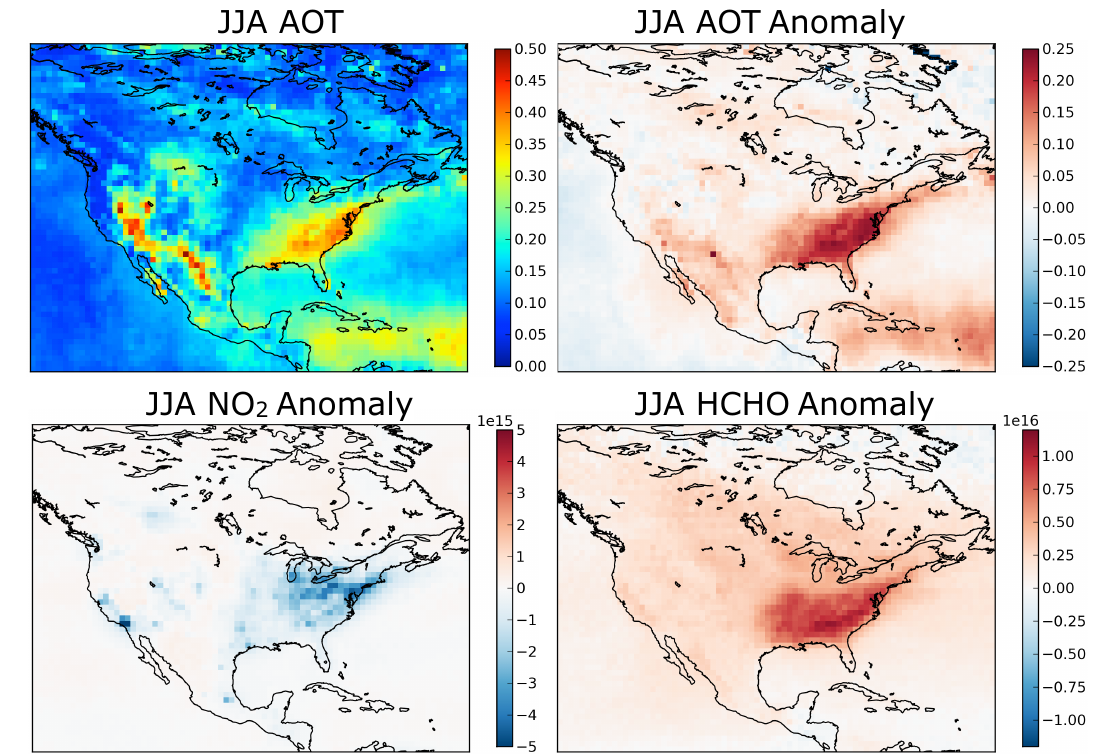
Fig. 7. Aerosol and trace gas anomaly for the summer months (June–July–August, JJA) over the United States. Top left panel: mean JJA AOT for the period 2005–2007. Top right panel: JJA AOT anomaly (summer months minus annual average) for the same period. Bottom left panel: JJA NO 2 anomaly. Bottom right panel: JJA HCHO anomaly.